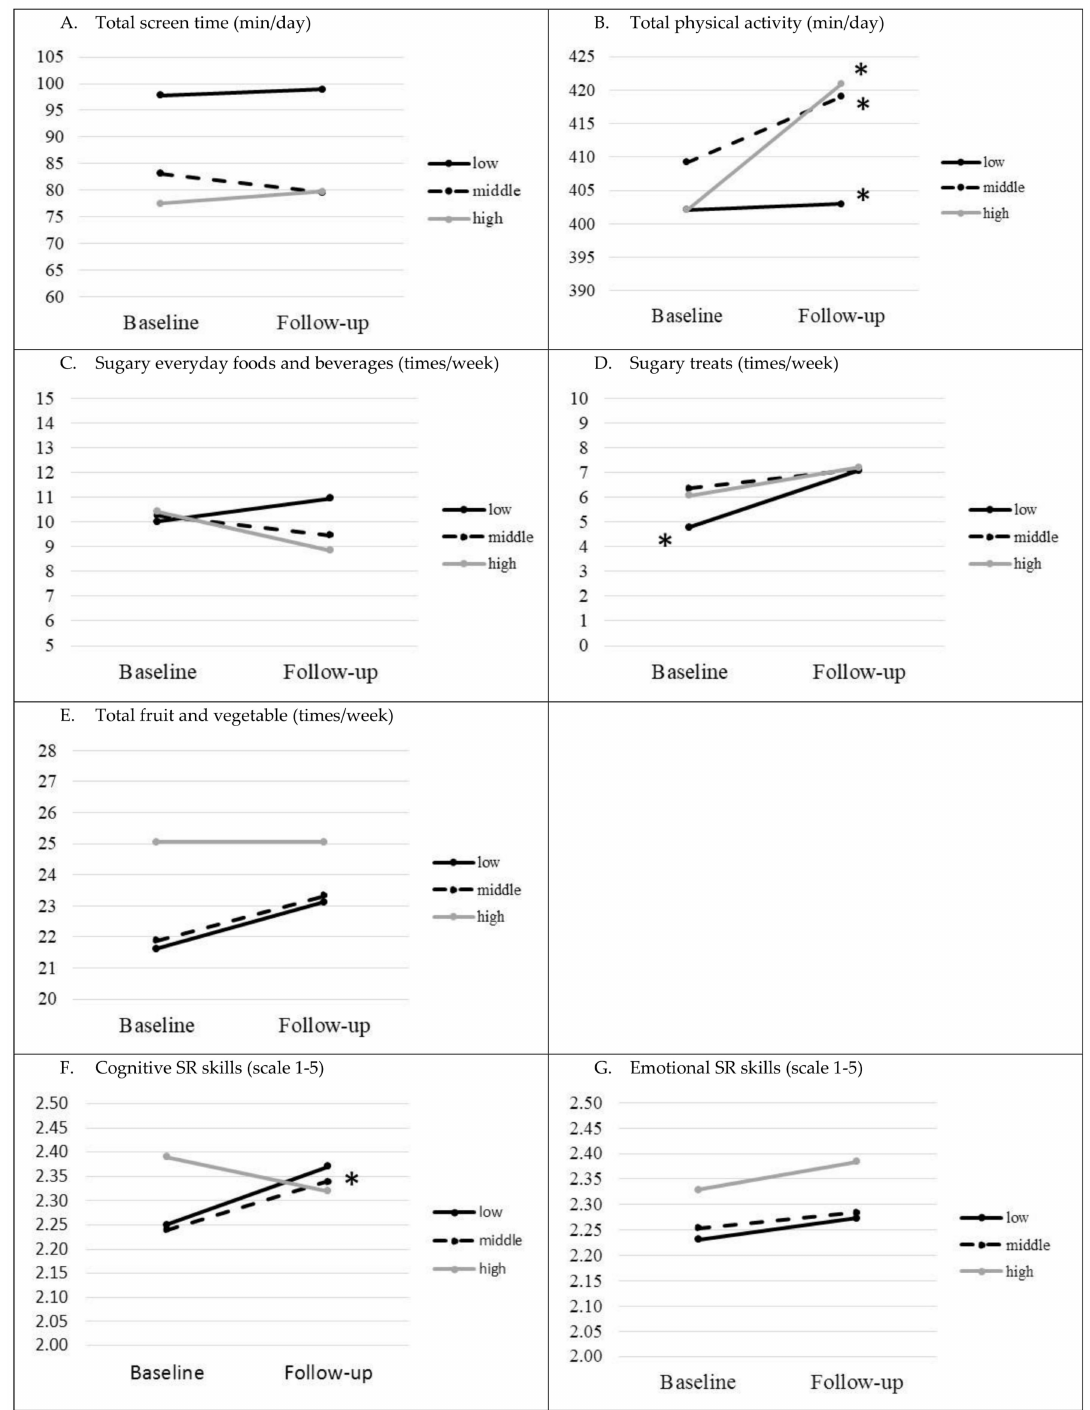
Figure 3. Children’s EBRBs (headings ( A – E )) and SR skills (headings ( F , G )) within the intervention group separated by highest parental educational level (PEL) (means). For exact mean values, please see Supplementary Table S2 (* p -value < 0.05 for di ff erence between follow-up and baseline within the